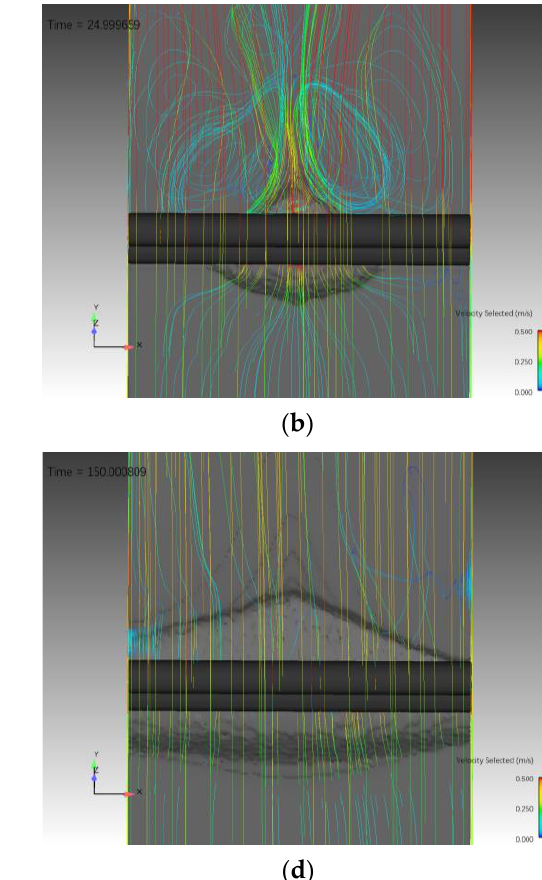
Figure 10. Variations of ( a ) S / D and ( b ) T * with intersecting angle α.